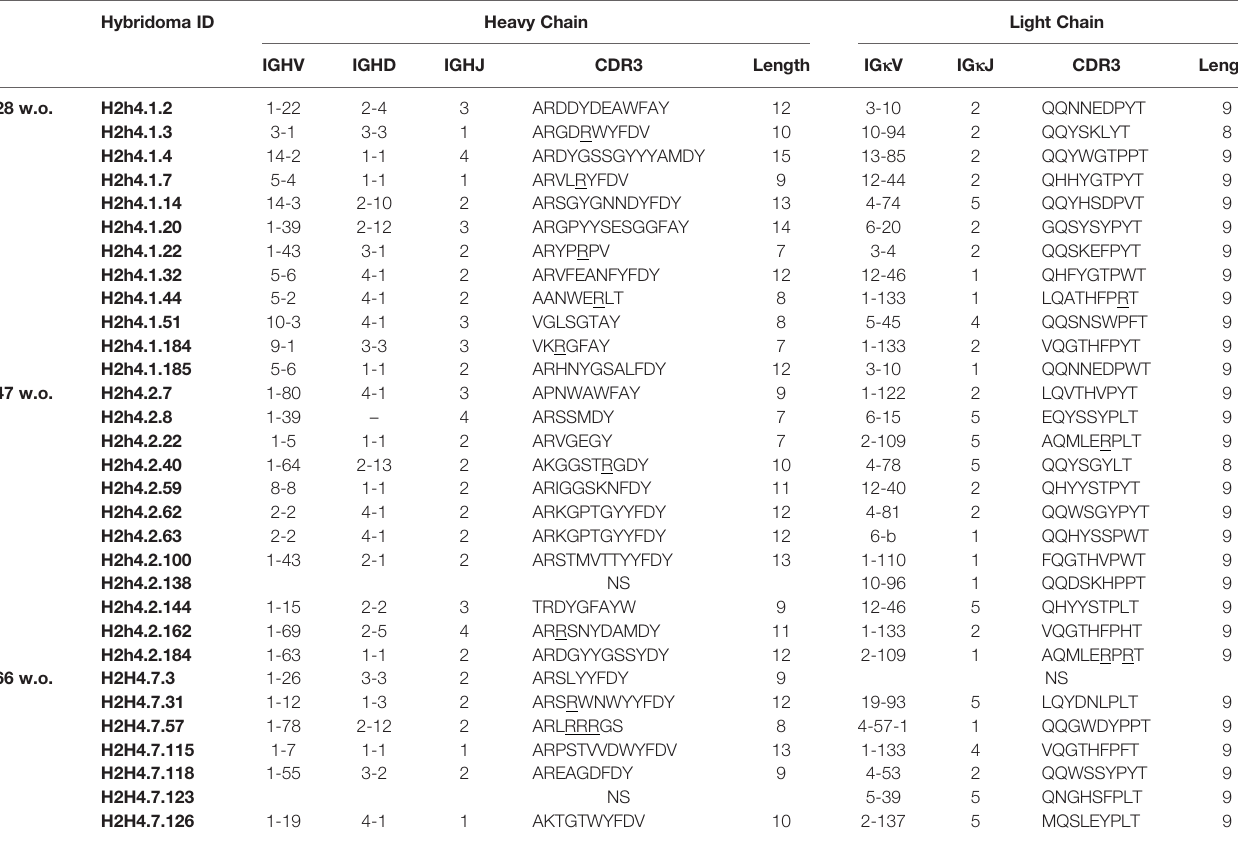
TABLE 1 | IGHV and IGKV of IgM antibodies derived from aging NOD.H-2 h4 mice (28, 47 and 66 w.o). Hybridoma ID Heavy Chain Light